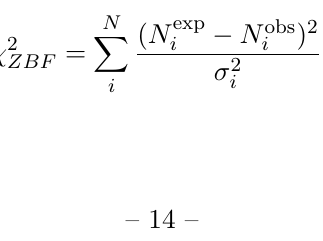
JHEP02(2022)176 = R